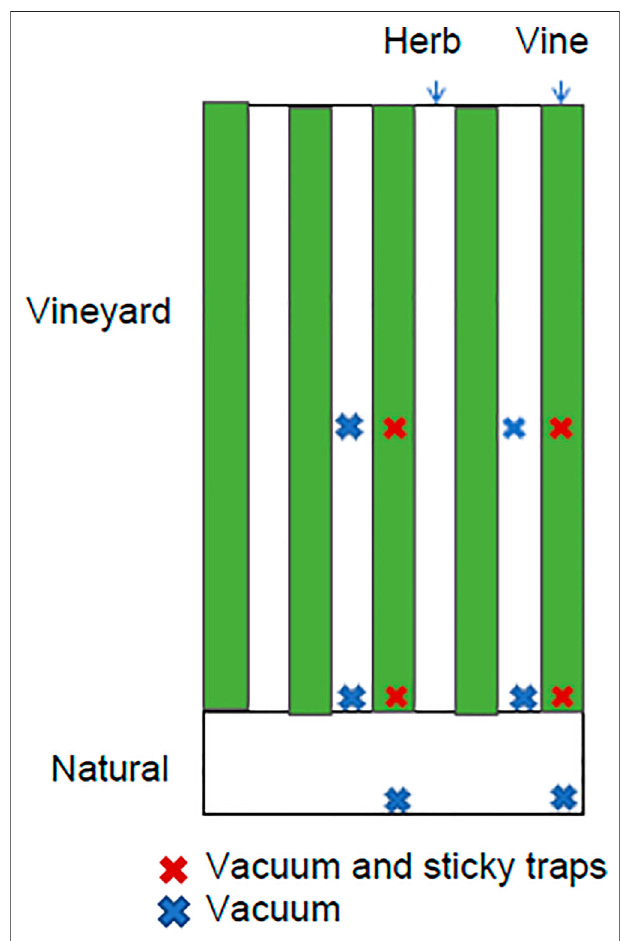
FIGURE 1 | Location of vacuum and sticky trap sampling points in each